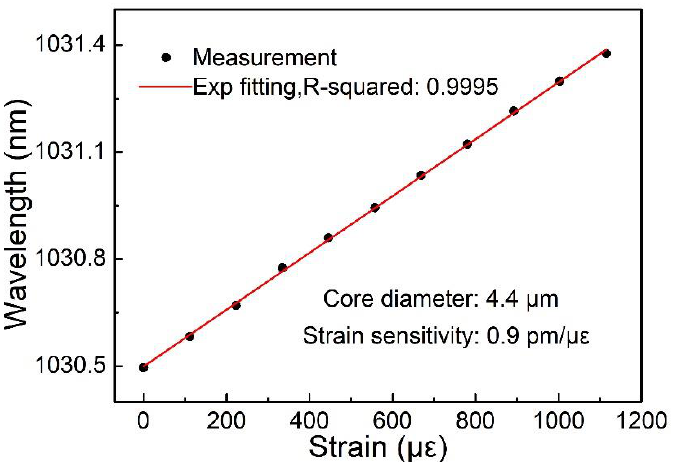
Figure 8. The relationship between the resonant wavelength of an apodized FBG with a core diameter of 4.4 μm and strain.